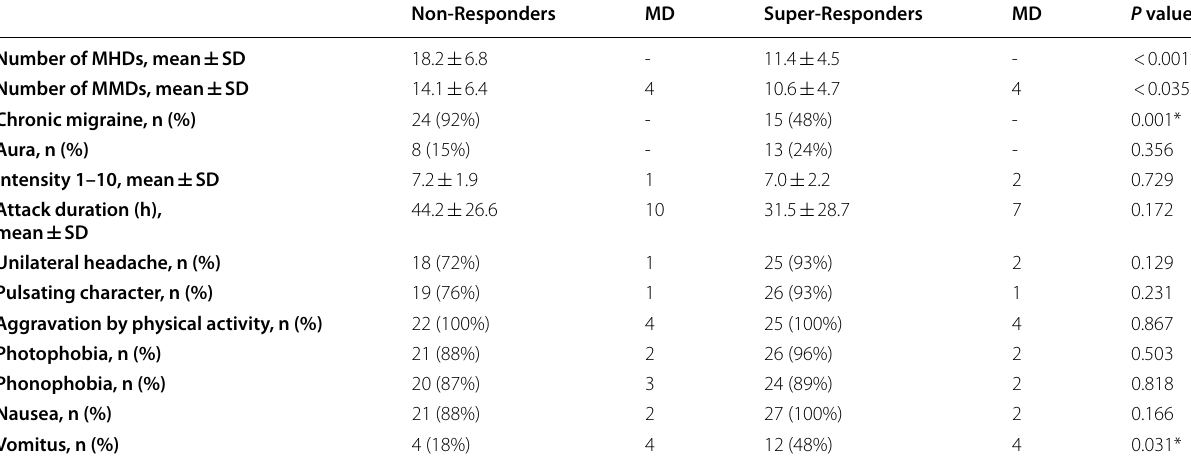
Table 3 Key headache baseline characteristics of Non-Responders and Super-Responders to CGRP(-R)